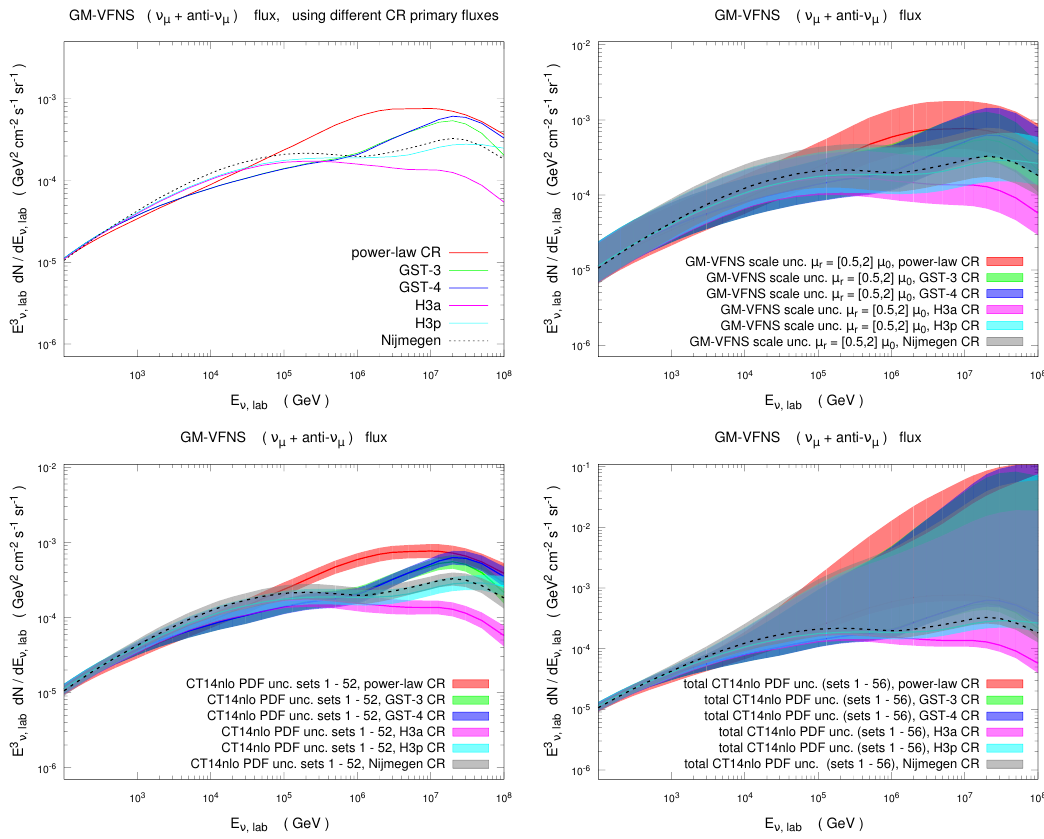
Figure 9 . Predictions for prompt-( (cid:23) (cid:22) + (cid:22) (cid:23) (cid:22) ) (cid:13)uxes as functions of neutrino energy E (cid:23) , according to the GM-VFNS computation presented in this paper, for di(cid:11)erent CR primary (cid:13)uxes used as input. Central predictions are shown in the upper left panel, renormalization scale uncertainties are shown in the upper right panel, whereas PDF uncertainties are shown in the lower panels, separating the contribution due to the Hessian sets (1{52) (lower left) from the total one due to all 56 PDF sets (lower right) included in the CT14nlo (cid:12)t. See text for more details.